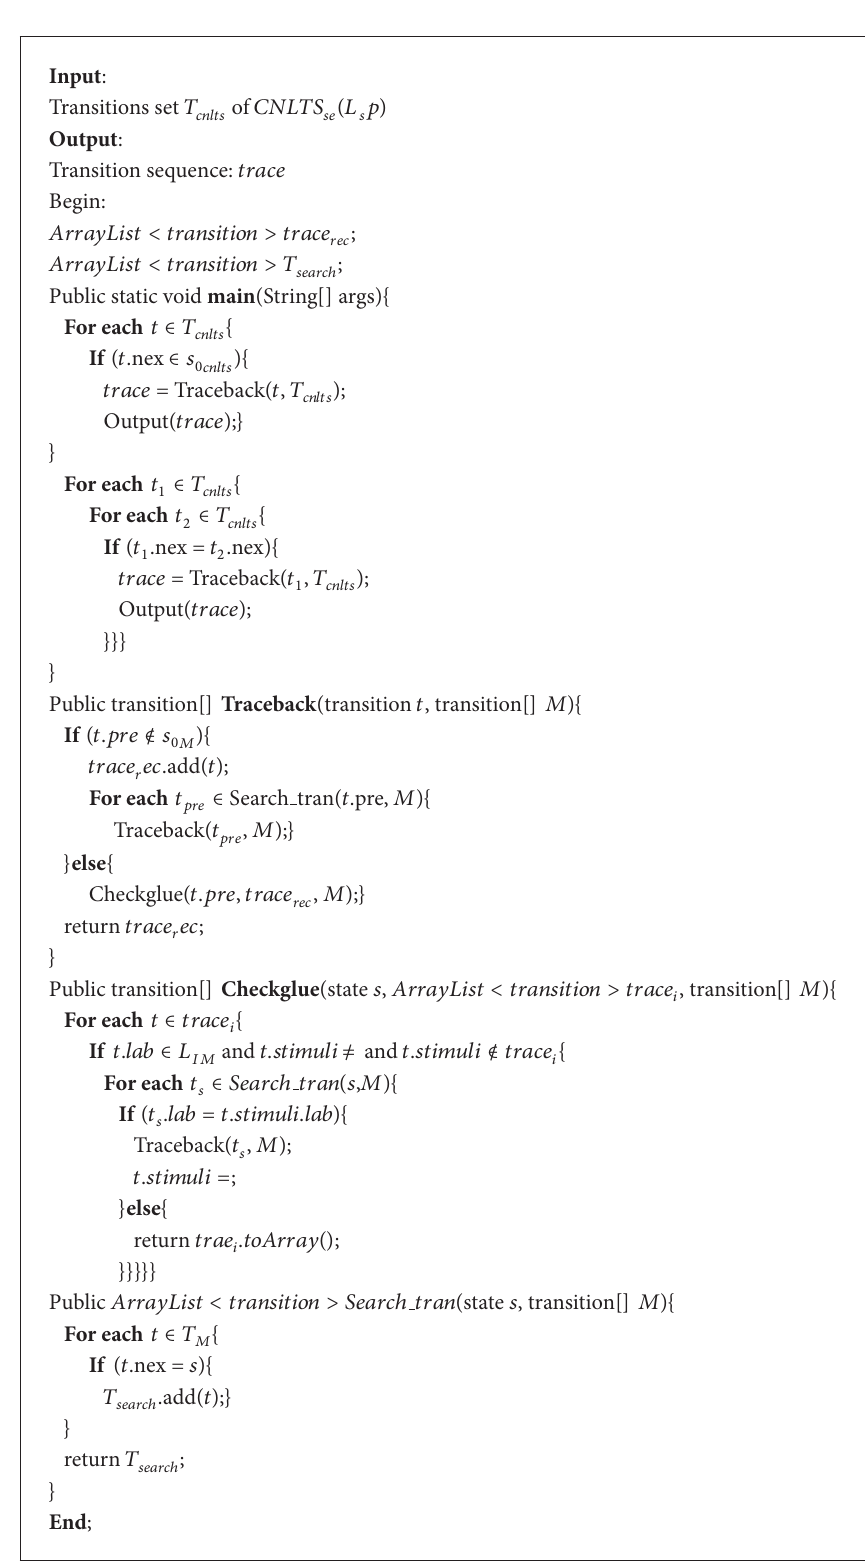
Algorithm 1: Test generation